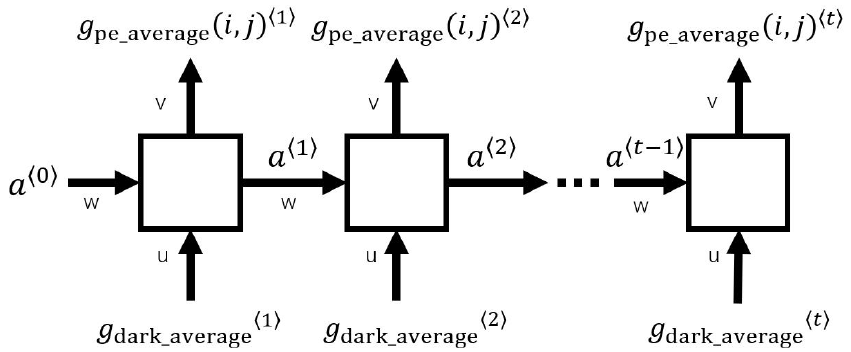
Figure 6. Model of feature data built using RNN.